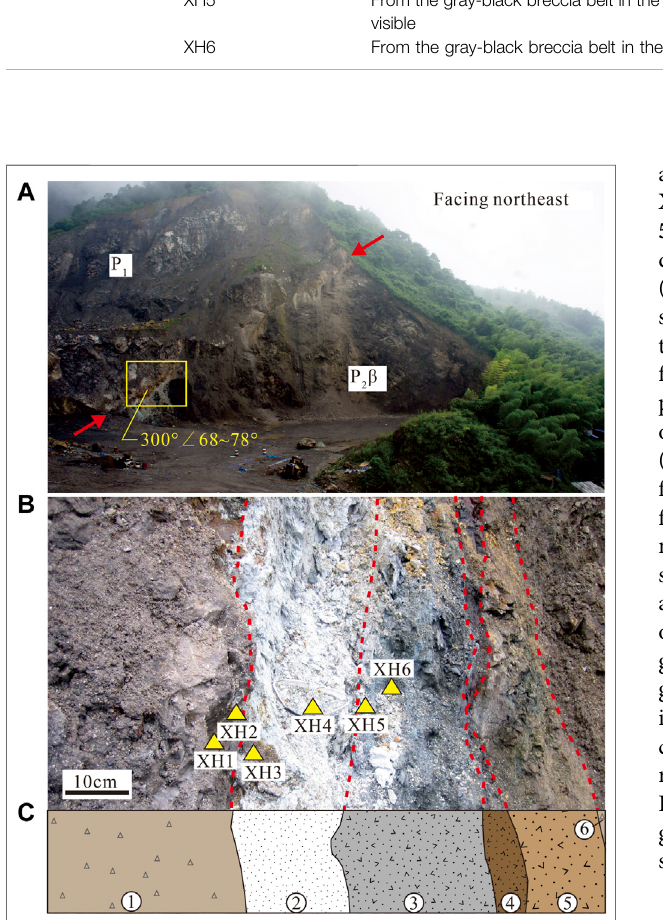
FIGURE 4 | (A) Photograph of the Xiaohe site (location shown in Figure 1B ) with the fault trace denoted by red arrows. P 1 : Lower Permian limestone and P 2 β : Upper Permian basalt. The sampled area is shown by the yellow box, which is enlarged in (B) and contains the fault gouge sample sites XH1 – XH6 (yellow triangles). (C) Interpretation of the fault belt. ① Cataclasite at the hanging wall, ② gray-white fault gouge, ③ gray-black